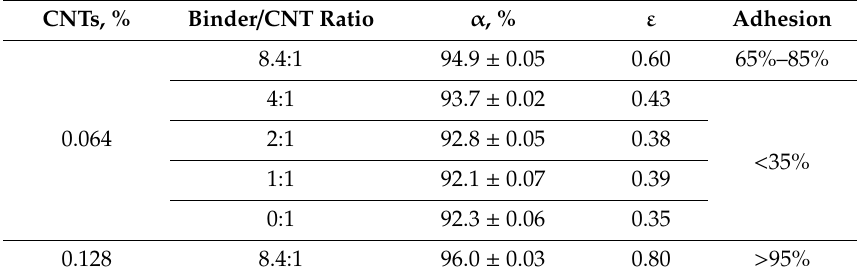
Table 2. Effect of binder/CNT weight ratio on the properties of the coatings with 0.064% CNTs. The properties of the coating with 0.128% CNTs are presented for comparison.